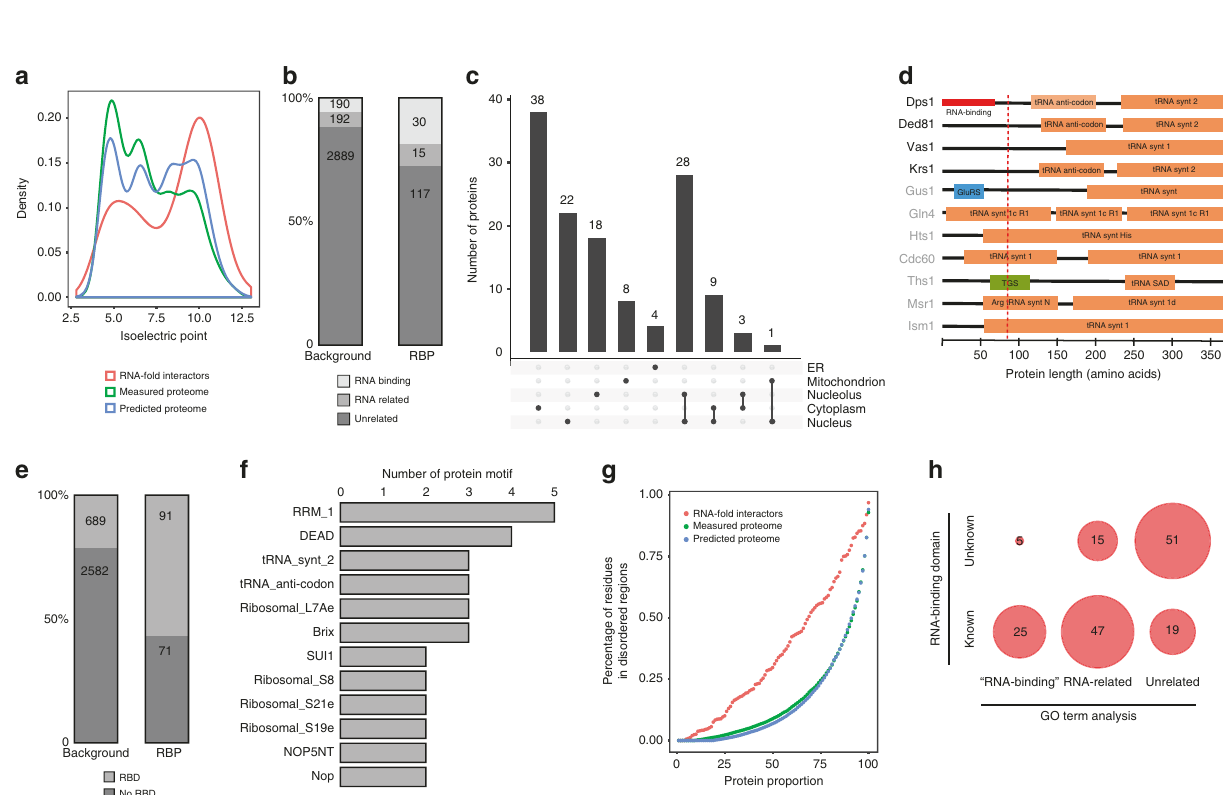
Fig. 1 Work fl ow and results for identi fi cation of proteins enriched at evolutionary conserved RNA folds. a Schematic of the SILAC-based quantitative RNA – protein interactomics work fl ow. b Conservation analysis of the conserved fold in the PMA1 mRNA by RNAz. Dots indicate unpaired bases and brackets paired bases. Gray bars represent sequence conservation among the indicated 5 yeast species. Folded structure shown on the right, with positional entropy values ranging from red/yellow (lower entropy) to green/blue (higher entropy). c Two-dimensional interaction plot comparing the interactors for PMA1 wild-type hairpin with the mutated fold. d Heatmap showing enrichment values for the 162 protein-binding partners to the 186 investigated RNA folds. e Venn diagram showing overlap of interactors according to genomic position of the RNA fold (5 ′ UTR, CDS, 3 ′ UTR). f Dot-plot displaying the number of binders identi fi ed to each investigated RNA fold grouped by localization within the mRNA (13 5 ′ UTR, 136 CDS and 37 3 ′ UTR RNA folds) (Supplementary Data 2).